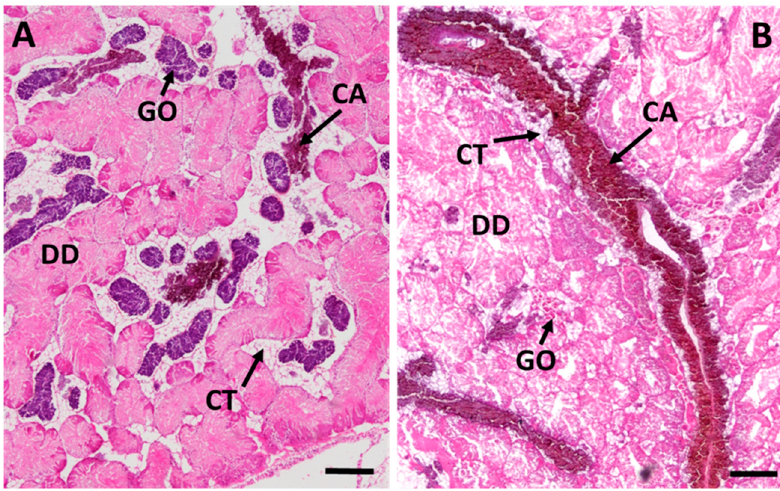
Figure 9. Overall view of the midgut gland/gonad complex stained with hematoxylin-eosin. ( A ) control periwinkle (male); ( B ) a periwinkle of the CdH group after 21 days of exposure (female). Scale bars: 200 µm; Abbreviations: DD: digestive tubular diverticula, CA: Connective Tissue Calcium cells, CT: connective tissue; GO: gonad tissue.